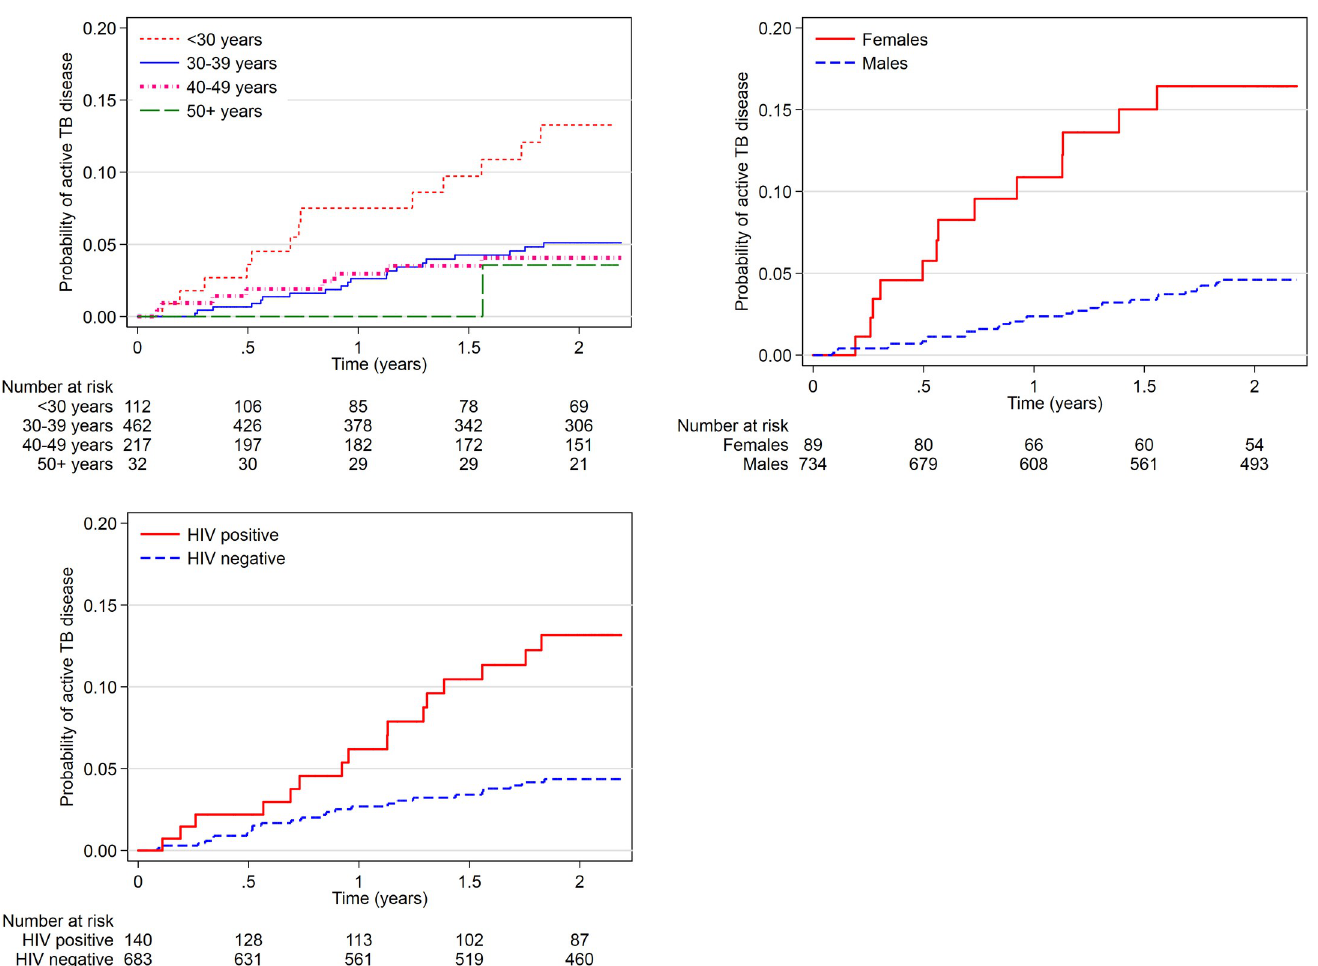
Fig 3. Factors associated with incident TB disease among people receiving medication-assisted treatment for substance use disorder in Dar es Salaam, Tanzania; Kaplan Meier plot (n = 823, incident TB = 42).